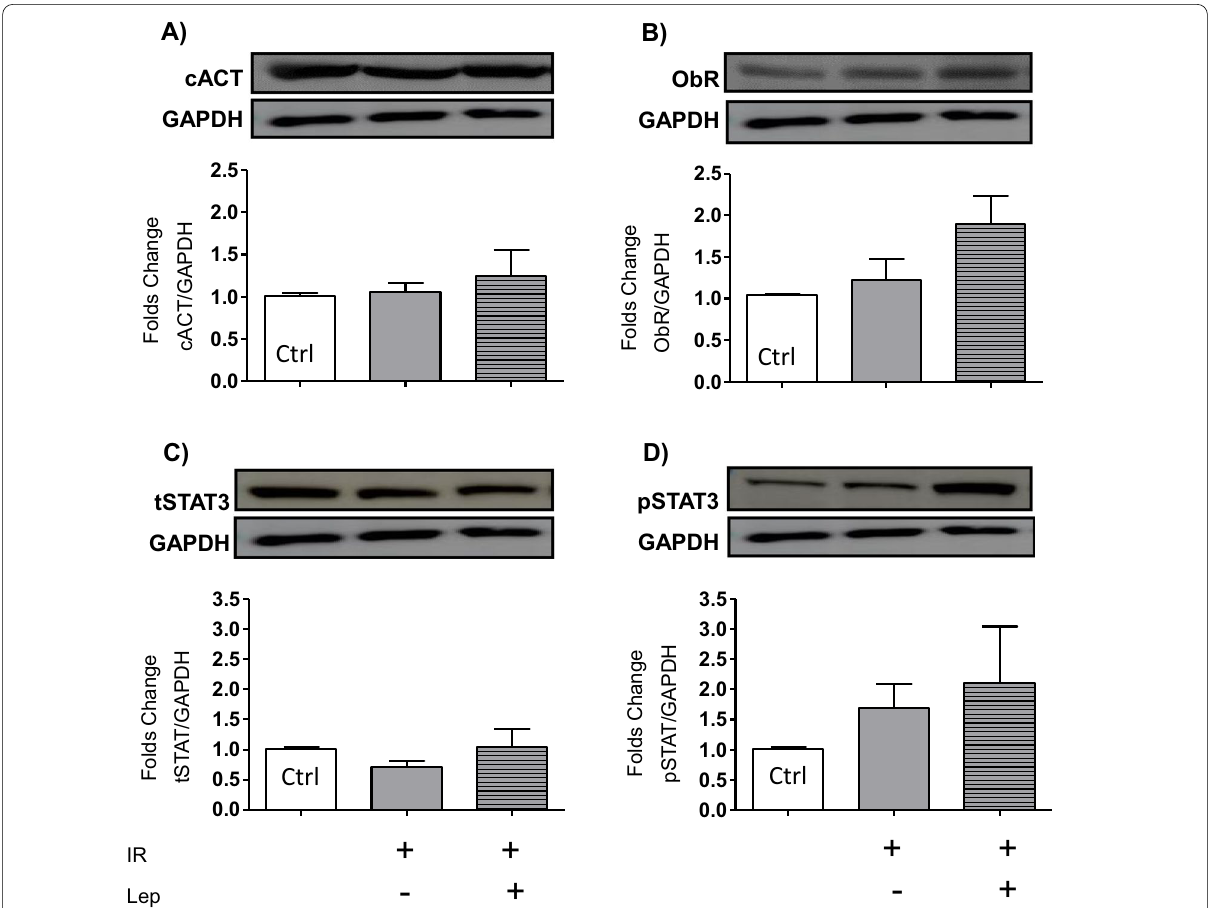
Fig. 3 Leptin does not change the expression of pro‑hypertrophy‑associated cACT, ObR, or STAT3 in heart homogenates. A cACT content; bars represent the median SEM of three independent preparations; B ObR content. C Total STAT3 and D phosphorylated STAT3 content; values indicate ± the mean SEM, n 3. GAPDH was used as loading control. cACT cardiac actin (alpha‑actin); ObR b isoform of the leptin receptor; STAT3 signal ± = transducer and activator of transcription 3 total ( t ) and phosphorylated ( p